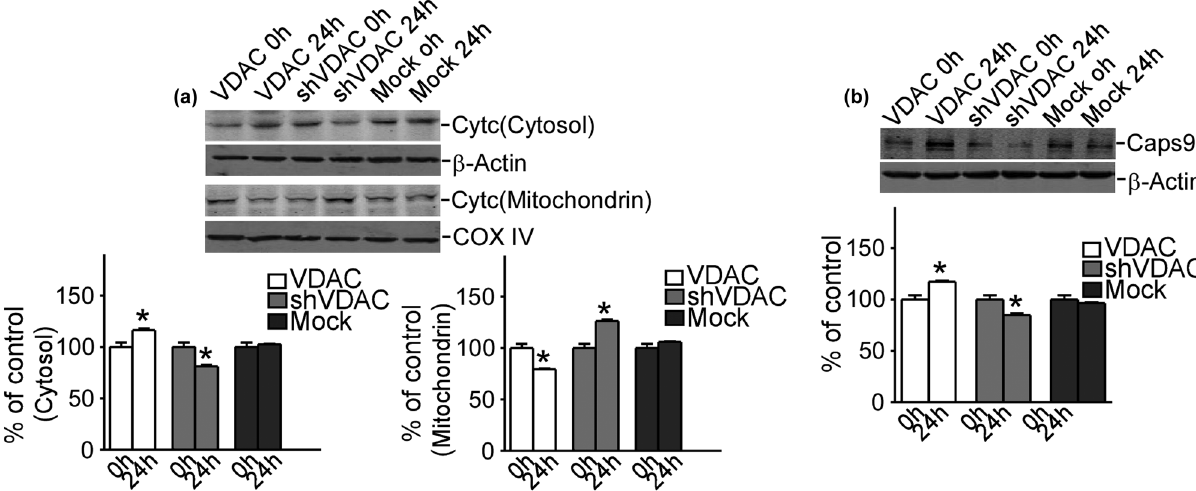
Figure 2: VDAC1 increased the release of cytochrome C and expression of caspase 9. ( a ) The changes of Cyt C in mitochondria and cytosol with upregulation and downregulation of VDAC1. ( b ) The changes of Caps9 with upregulation and downregulation of VDAC1. Cyt C means cytochrome C , Caps9 means caspase 9. Values represent means ± SD, n = 3. P < 0.05 by Student ’ s t -